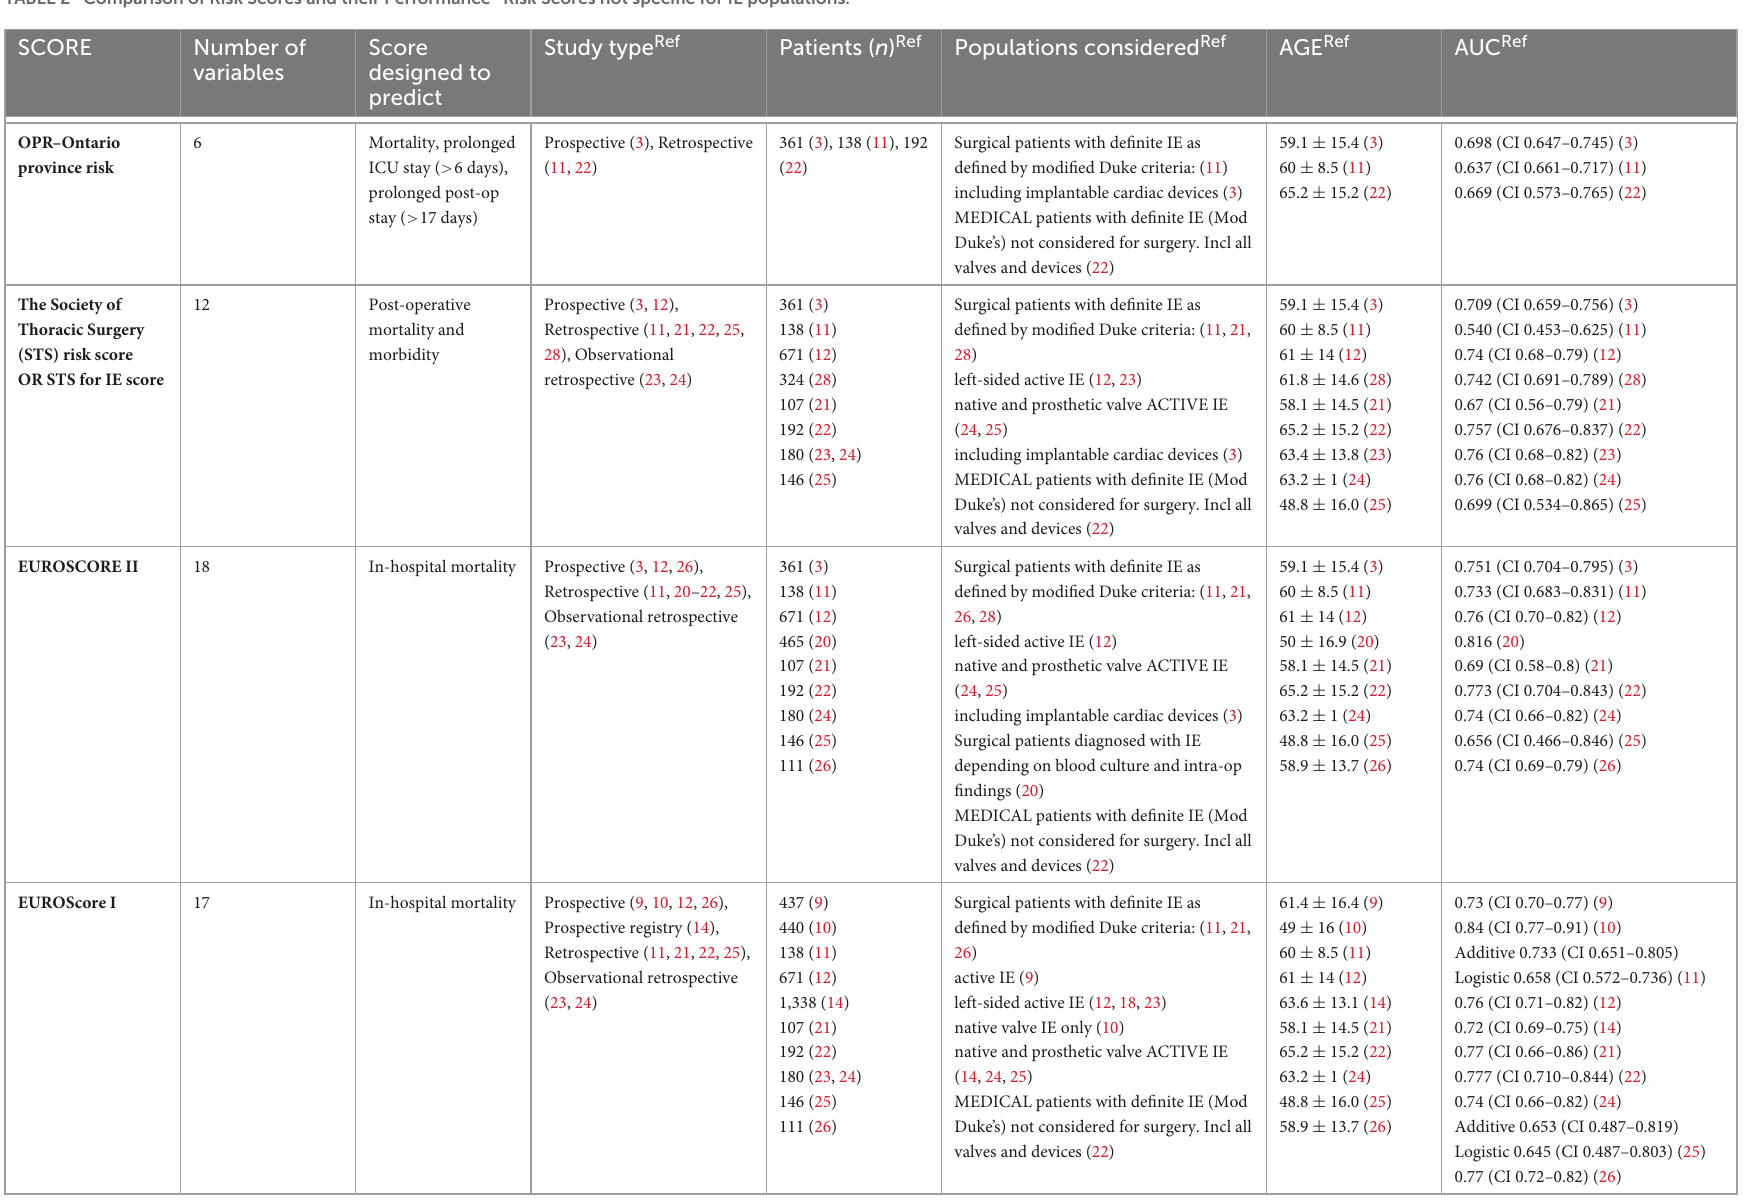
TABLE 2 Comparison of Risk Scores and their Performance–Risk Scores not specific for IE